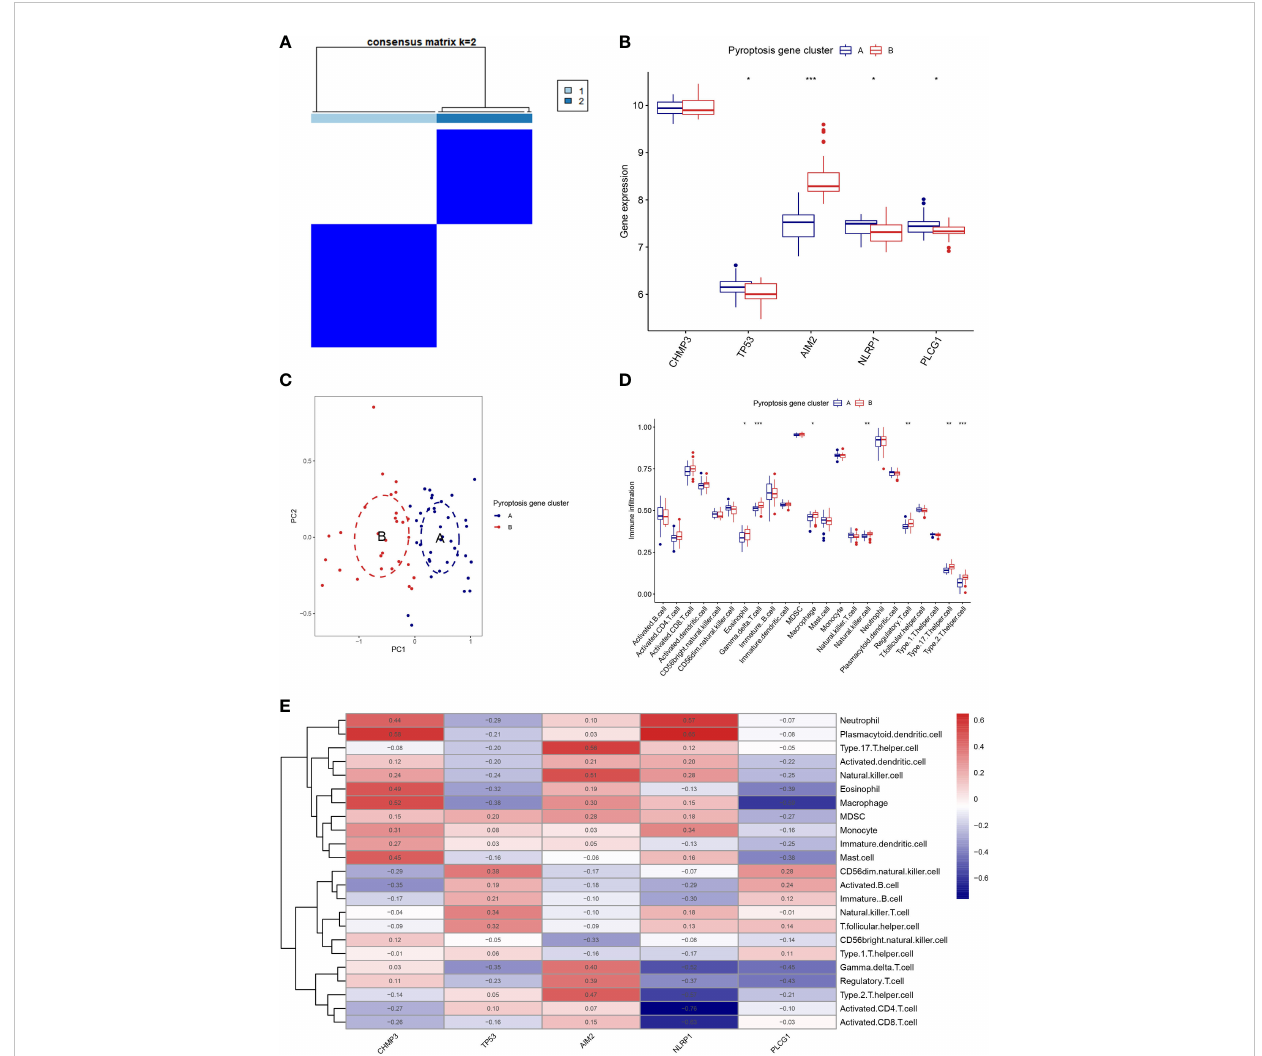
FIGURE 3 Consensus clustering of the 5 PRGs. (A) Consensus matrices of the 5 PRGs for k = 2. (B) Differential expression histogram of the 5 PRGs in gene cluster A and B. (C) PCA for the expression pro fi les of the 5 PRGs. (D) Differential immune cell in fi ltration between gene cluster A and B. (E) Correlation between in fi ltrating immune cells and the 5 PRGs. * means P < 0.05, ** means P < 0.01, *** means P < 0.001.